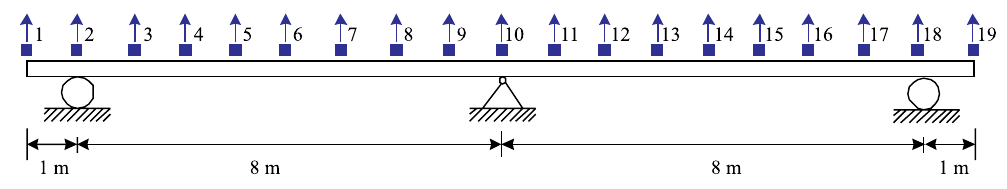
Fig. 3. Accelerometer layout of experimental